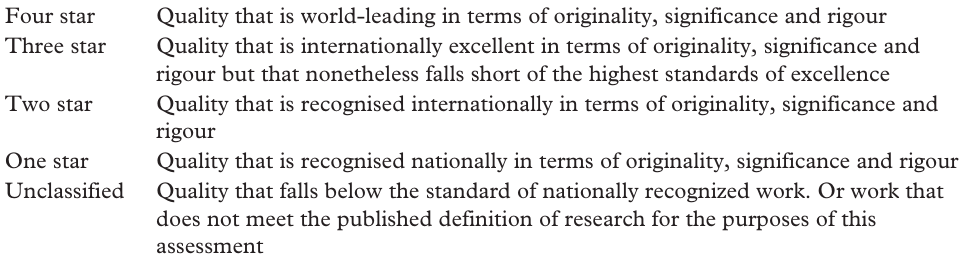
Table 1. Definitions of quality